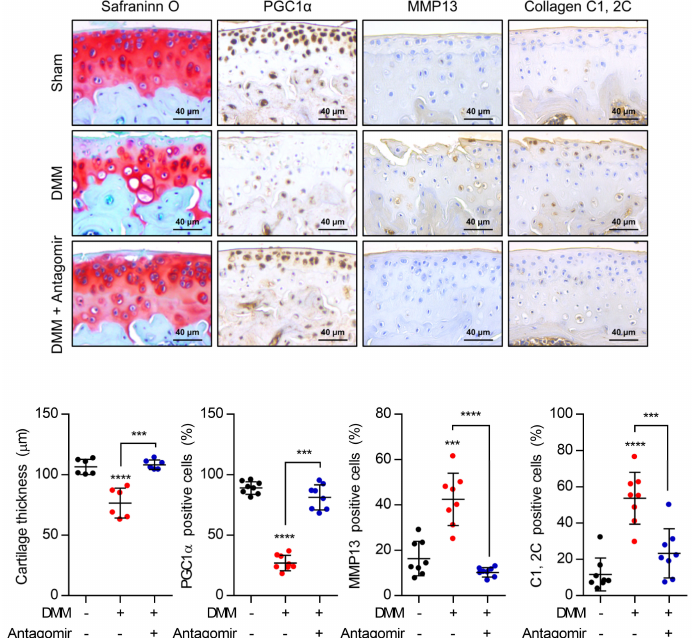
Figure 5. miR-126-5p dysregulates the homeostasis of the cartilage matrix. Mouse cartilages induced by destabilization of the medial meniscus (DMM) were infected with lentiviruses containing miR- 126-5p inhibitor (Antagomir). The expression level of PGC1a, MMP13, and Collagen C1, 2C were analyzed (upper panel). Positive cells were counted as three different fields/experiments, averaged, and represented as a dot graph (lower panel). Results are representative of at least three independent experiments. Values were expressed as means ± s.d. An unpaired t -test or one-way ANOVA was used for statistical analysis. *** p < 0.001, **** p <